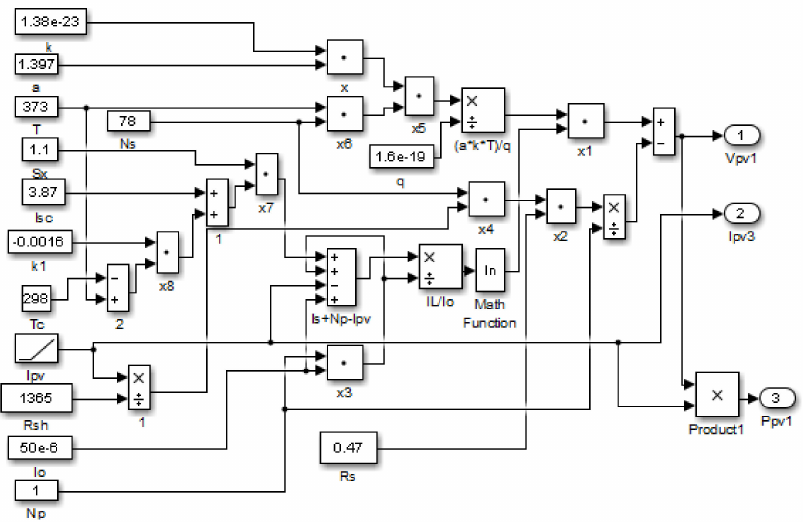
Figure 6. MATLAB / Simulink equivalent PV